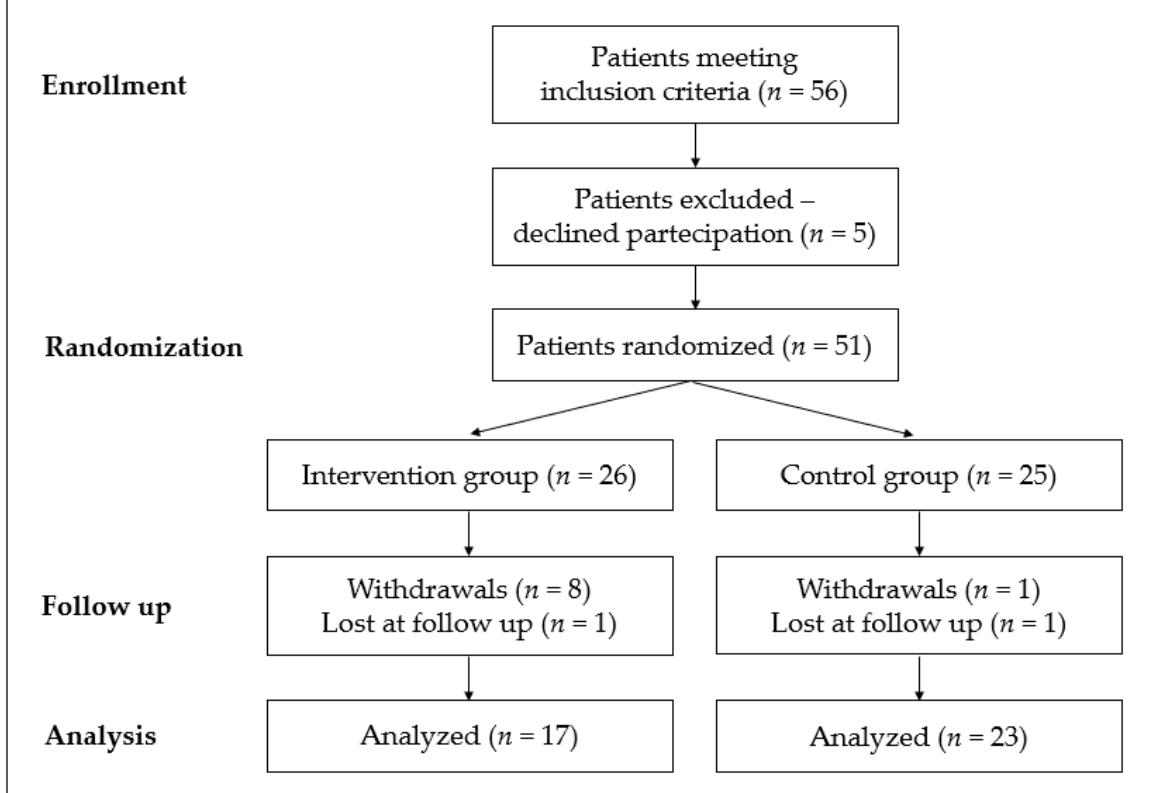
Figure 1. Study enrollment and randomization.